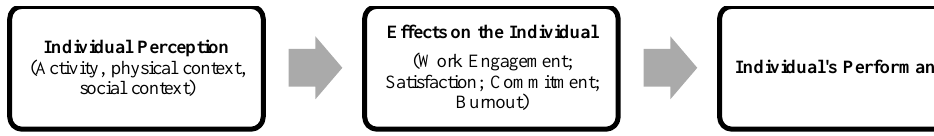
Figure 1: The Perception-Performance Relationship